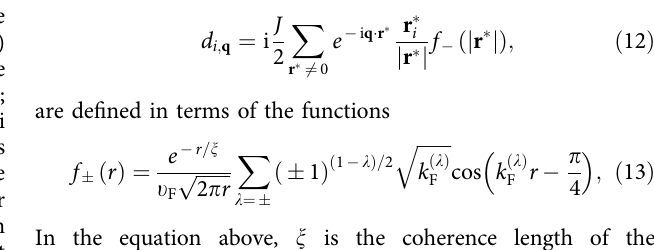
ffiffiffiffiffiffiffiffiffiffiffiffiffiffiffiffiffiffiffiffiffiffiffiffi p 2 m m þ a 2 m 2